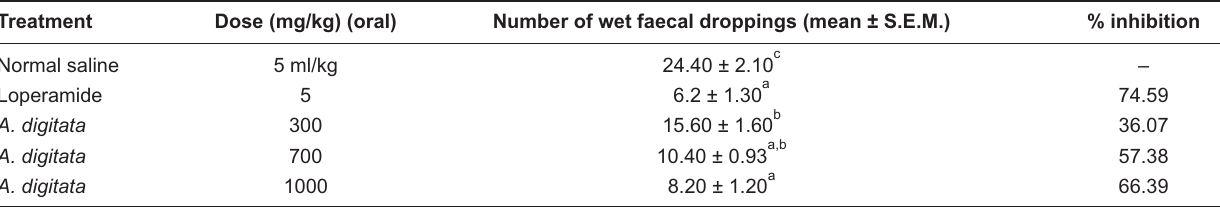
Figure-1: The effect of different doses of the extract of Figure-2: The protective effect of extract of on gastro-intestinal transit time of mice. (300-1000 mg/kg) on castor oil-induced diarrhoea Mice in the non-treated group were given normal saline (5 in mice. Values are mean ± S.E.M ***p < 0.0001, **p ml/kg). Values are mean ± S.E.M ***p < 0.001, **p 0.01 < 0.001 and **p < 0.05 show significant difference when and *p < 0.05 showed significant difference when compared compared with non-treated (normal saline) control with non-treated (normal saline) control group. Table-1: Effect of the extract of